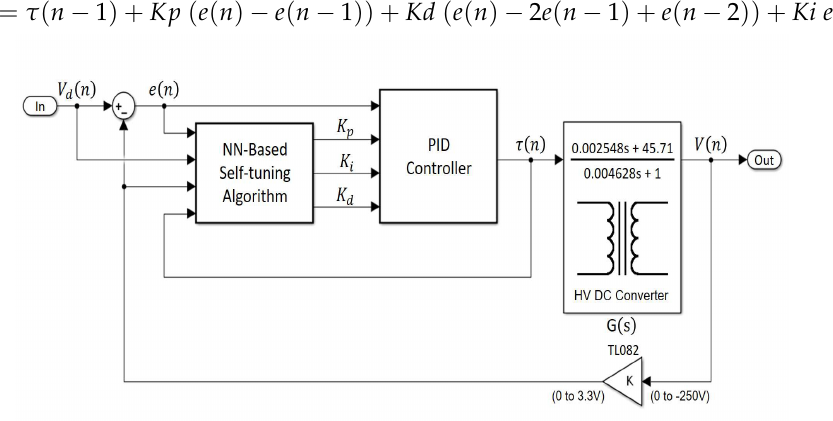
Figure 10. Experimental setup for the tuning process by the neural network